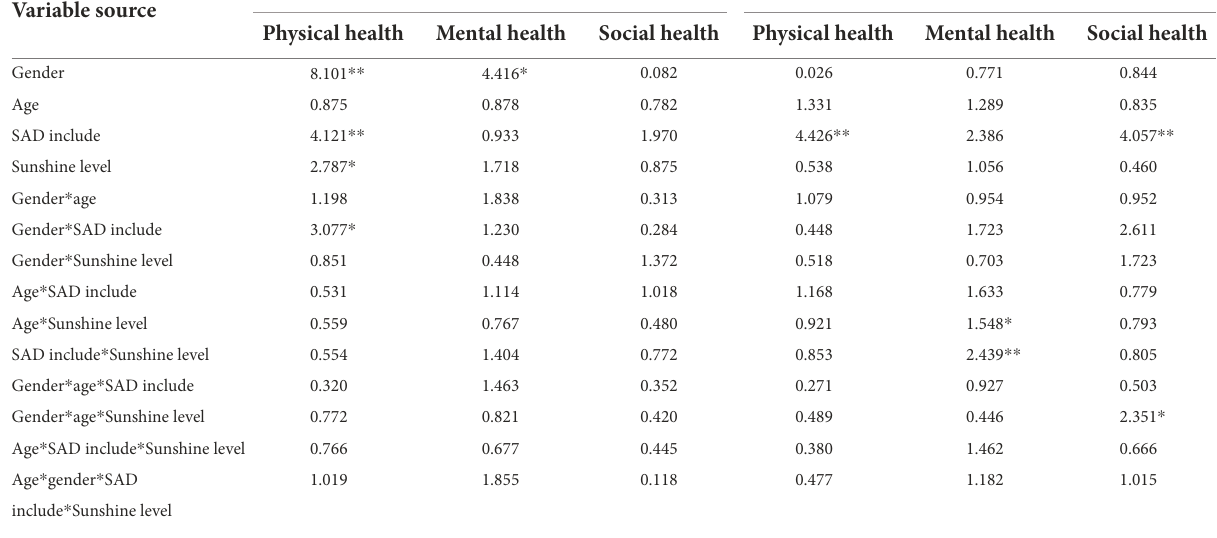
TABLE 6 Variance analysis of SAD winter symptoms RMT observation group ( n =